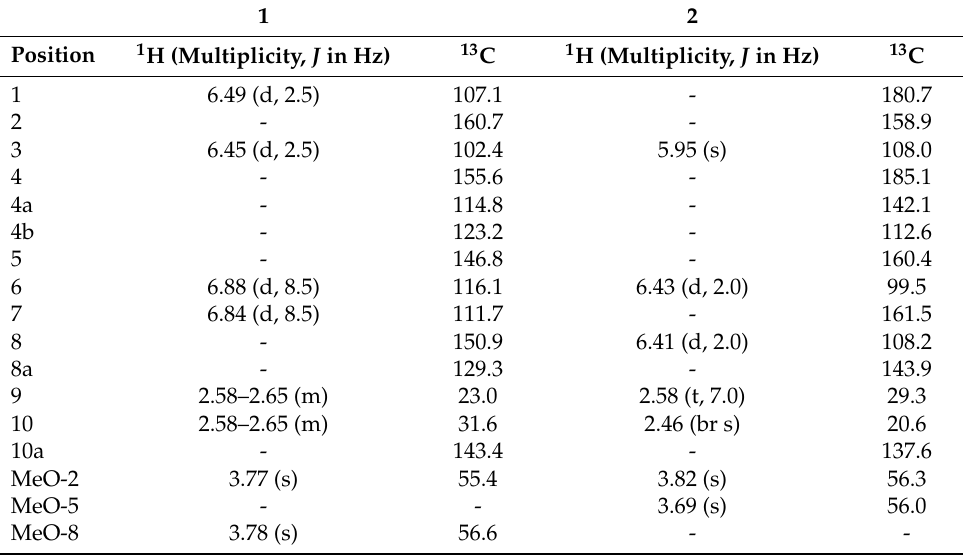
Table 1. 1 H (500 MHz) and 13 C NMR (125 MHz) spectral data of 1 and 2 in acetone- d 6